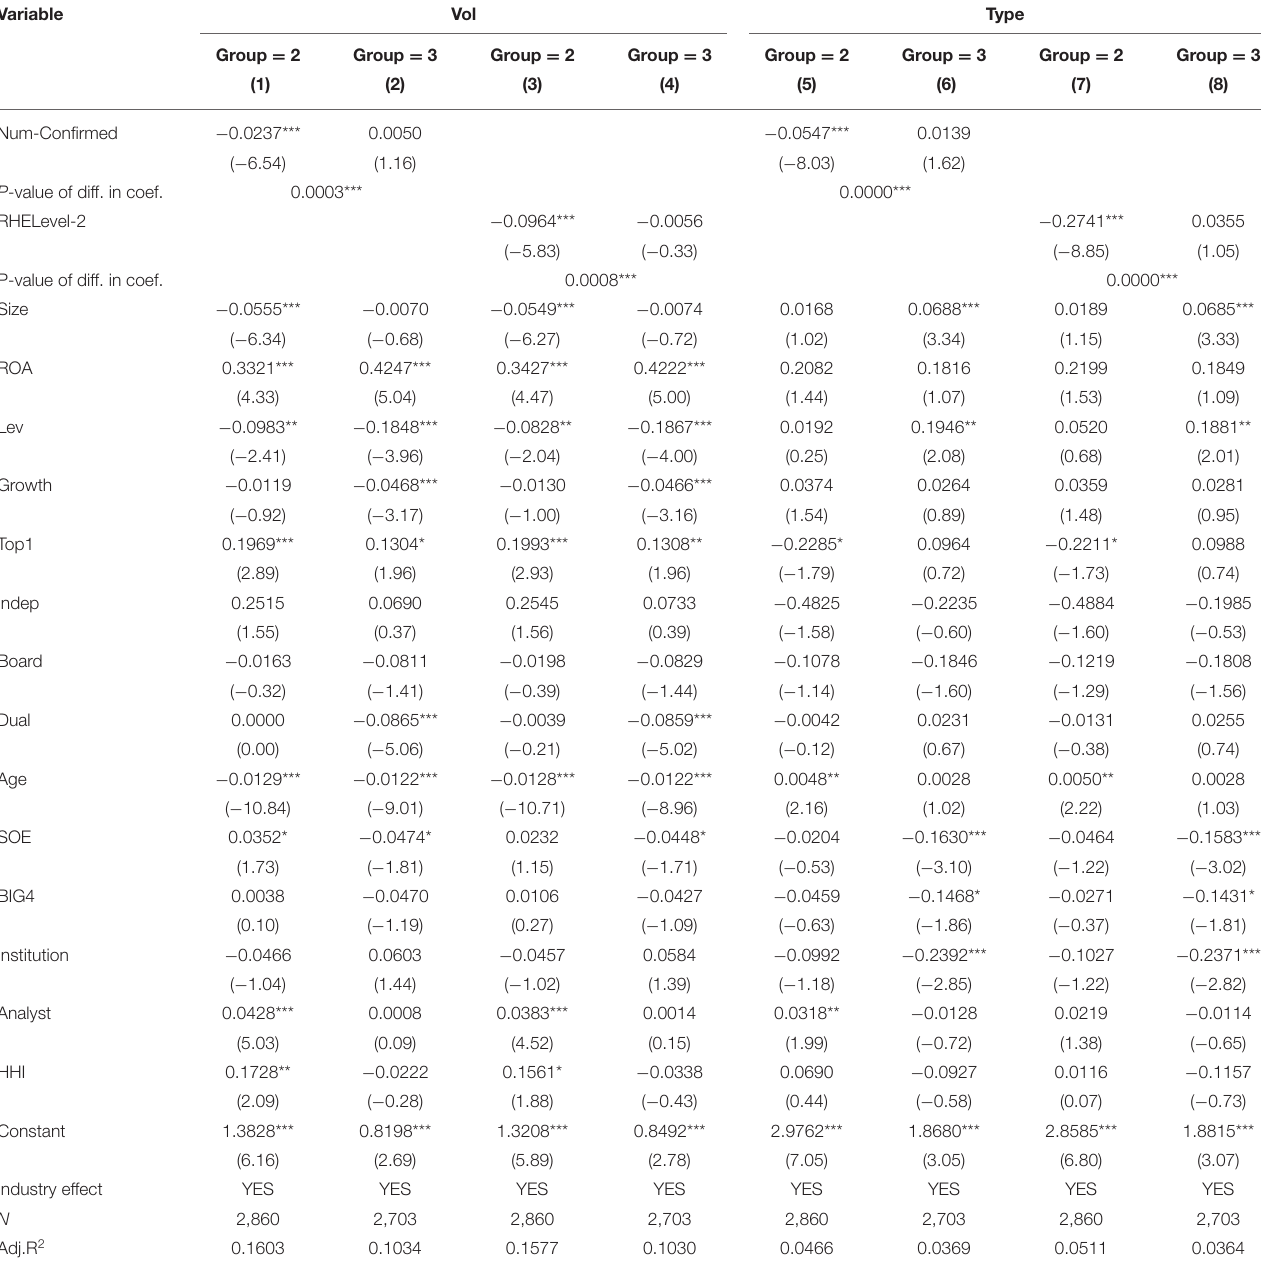
TABLE 16 | Impact of the COVID-19 and law environment on management earnings